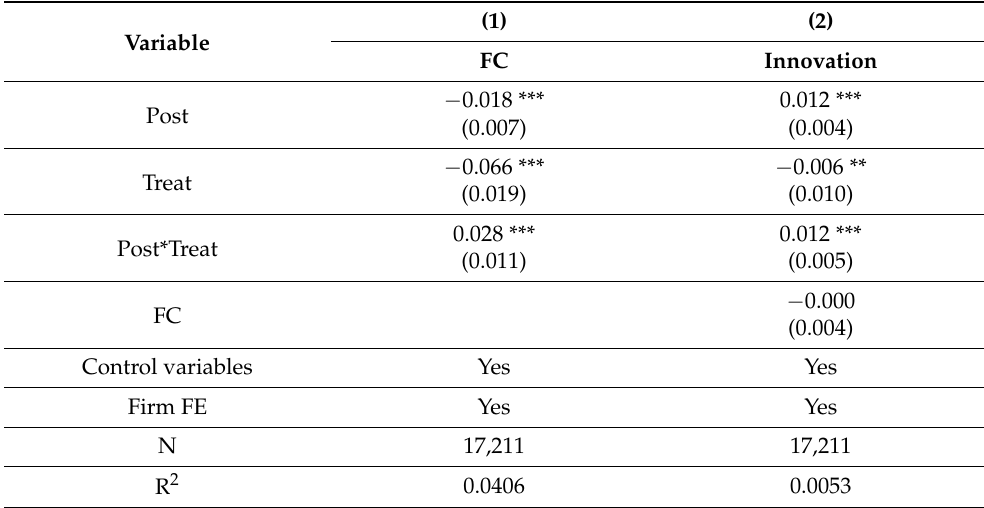
Table 7. An empirical test of green credit guidelines, financing constraints, and green technology innovation.